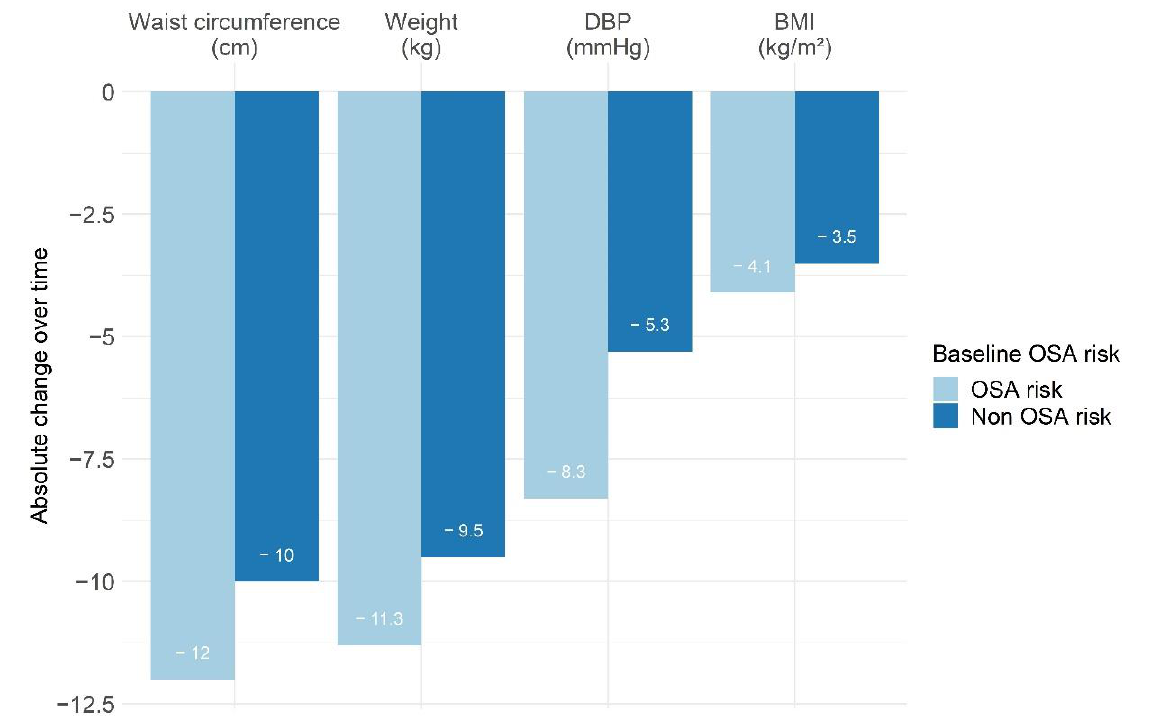
Figure 3. Non-adjusted significant absolute changes during the program in anthropometric markers of fat distribution associated with high cardiometabolic risk and blood pressure. DPB: diastolic blood pressure; BMI: body mass index. OSA: obstructive sleep apnea.